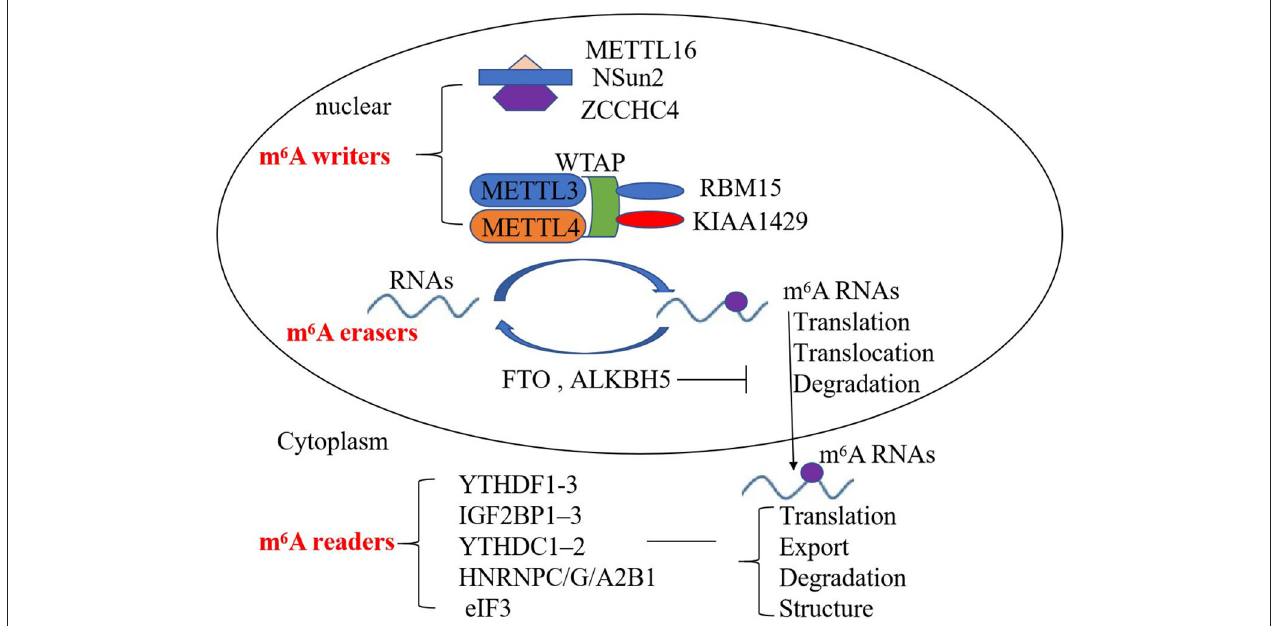
FIGURE 1 | Mechanism of the deposition of m 6 A modification on mRNA and non-coding RNAs. m 6 A writers, erasers, and readers regulate the deposition of m 6 A modification and affect the translocation, translation, stability, degradation, and structure of